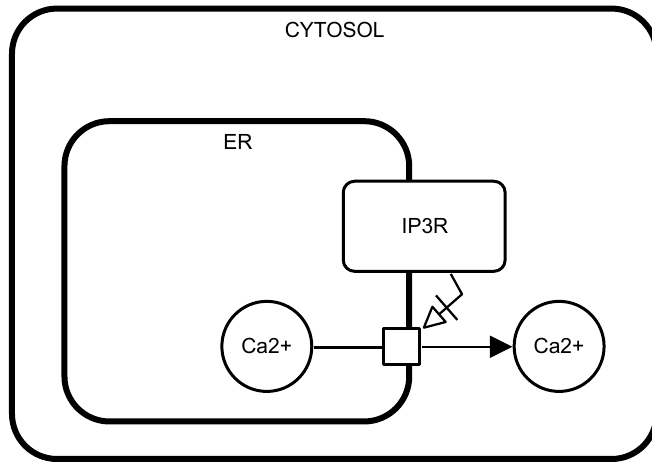
Figure 2.48: The transport of calcium ions out of the endoplasmic reticulum into the cytosol. Note that IP3R crosses both compartment boundaries. This is allowed, but the Macro- molecule should only belong to one of the compartments see section D.1 for more discussion of this